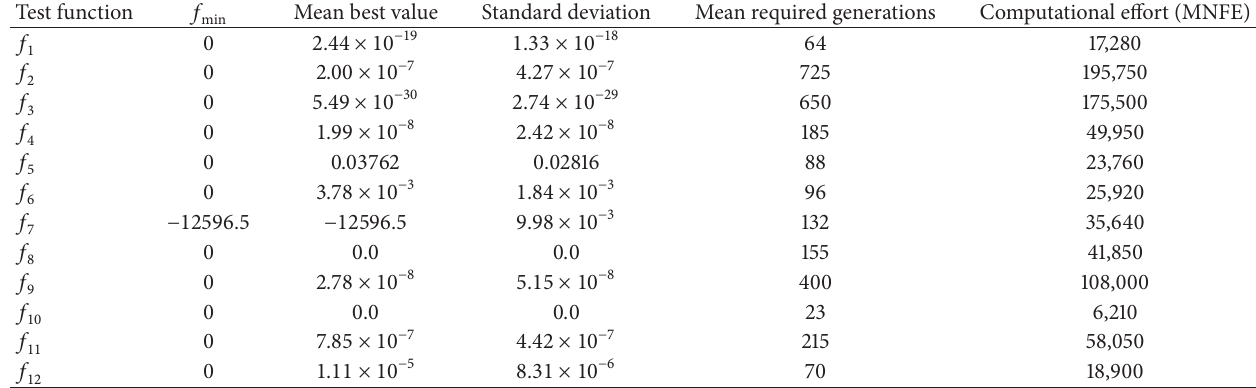
Table 2: Experimental results obtained by the MEGA over 50 independent trails.